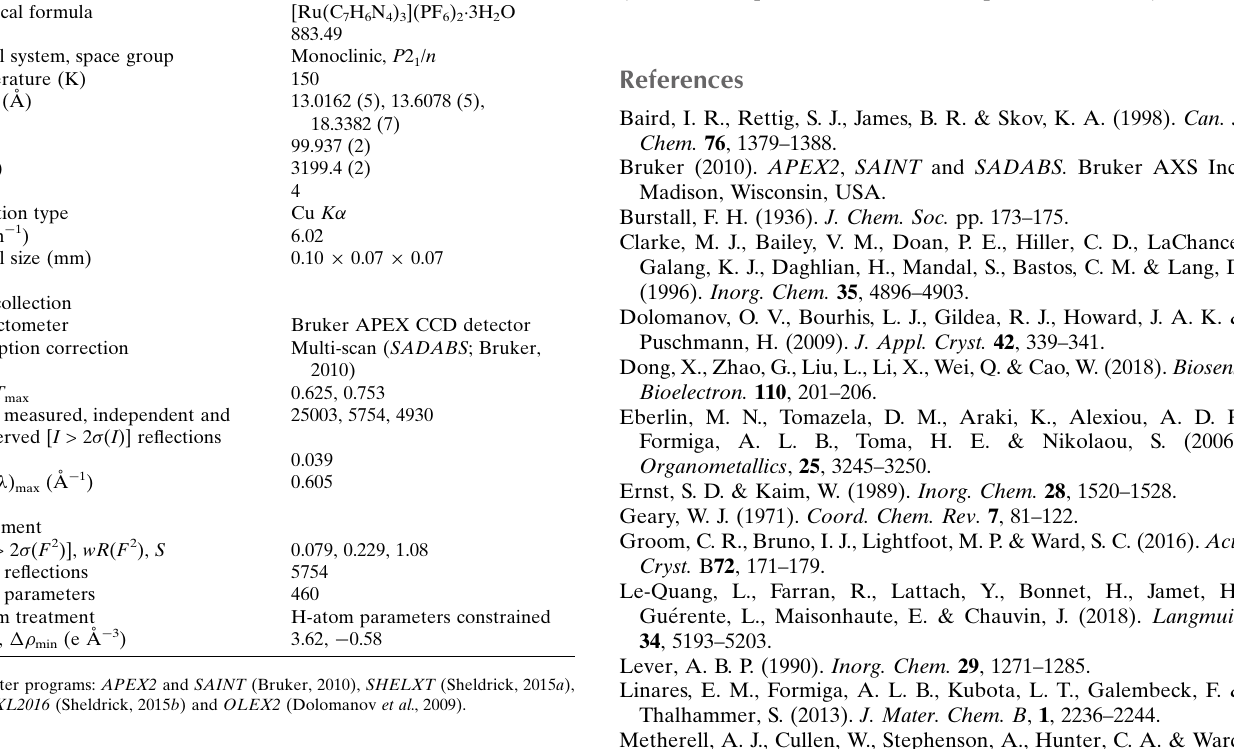
Table 2 Experimental details. Crystal data Chemical